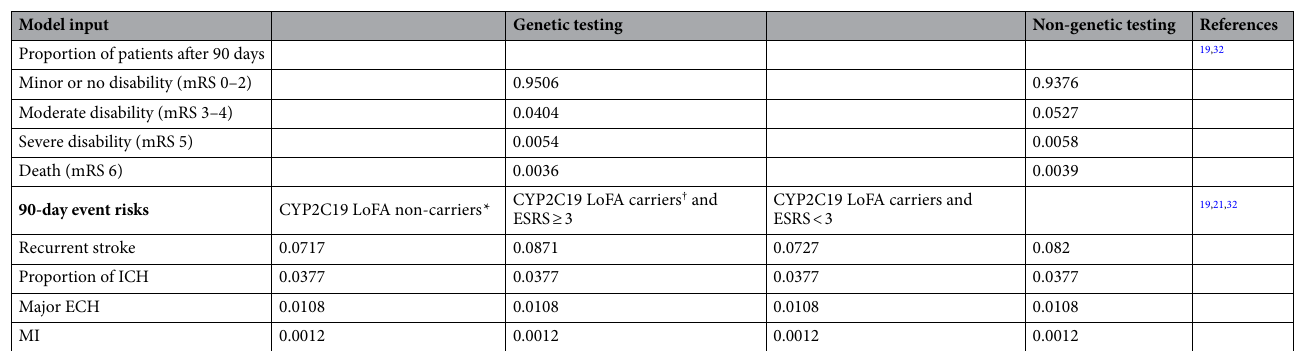
Table 2. Efficacy of Genetic testing regimen for minor stroke and acute TIA patients. Minor stroke minor stroke, TIA transient ischemic attack, mRS modified Rankin Score, ICH intracerebral hemorrhage, ECH extracranial hemorrhage, MI myocardial infarction. *CYP2C19 LoFA non-carriers were defined as patients without LoFA of *2 and *3 (*1/*1, *1/*17, or *17/*17). † CYP2C19 LoFA carriers were defined as patients with at least one LoFA of *2 or *3 (*1/*2, *1/*3, *2/*2, *2/*3, *3/*3, *2/*17, or